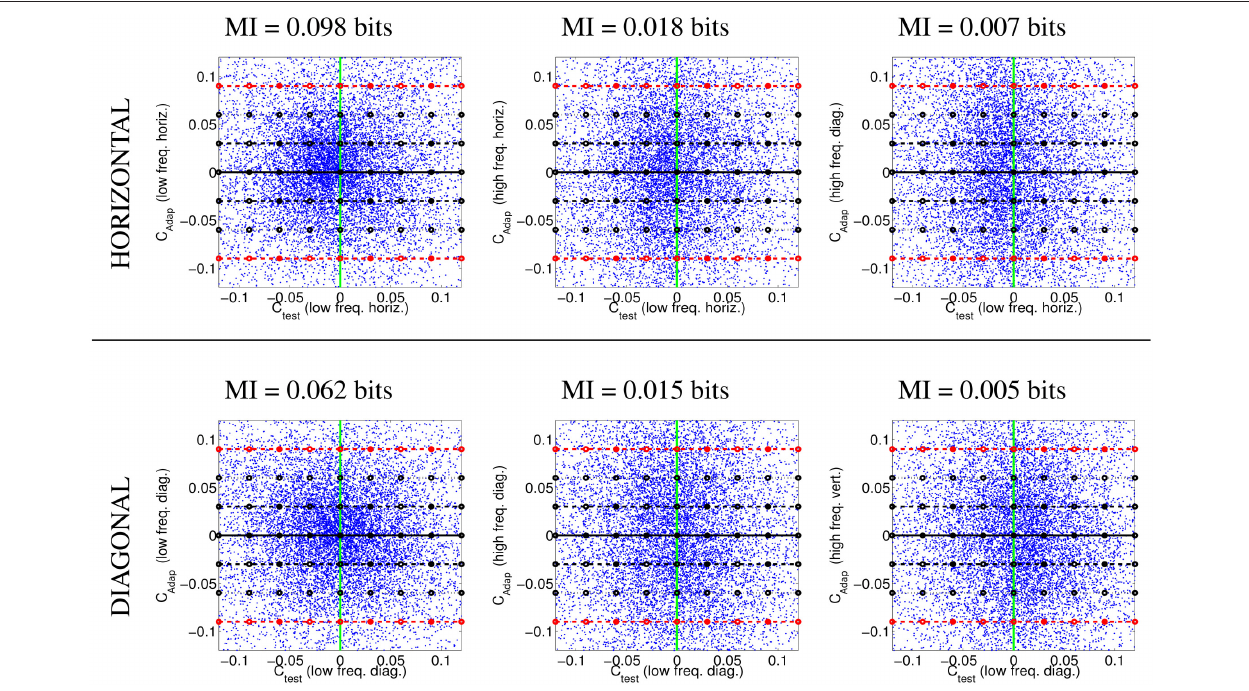
FIGURE 7 | Natural visual textures after the linear stage. Image patches projected on the axes defined by the linear receptive fields selected to describe the different adapting environments. Top row: projections on the low frequency horizontal analyzer and different additional analyzers: low frequency horizontal (left), high frequency horizontal (center), and high frequency diagonal (right). Bottom row: projections on the low frequency diagonal analyzer and different additional analyzers: low frequency diagonal (left), high frequency diagonal (center), and high frequency vertical (right). The mutual information numbers (MI in bits) above each plot show that the relation between linear responses decreases as the distance in frequency increases. As in the motion experiments, the magnitude of the linear responses are expressed in contrast (amplitude over standard